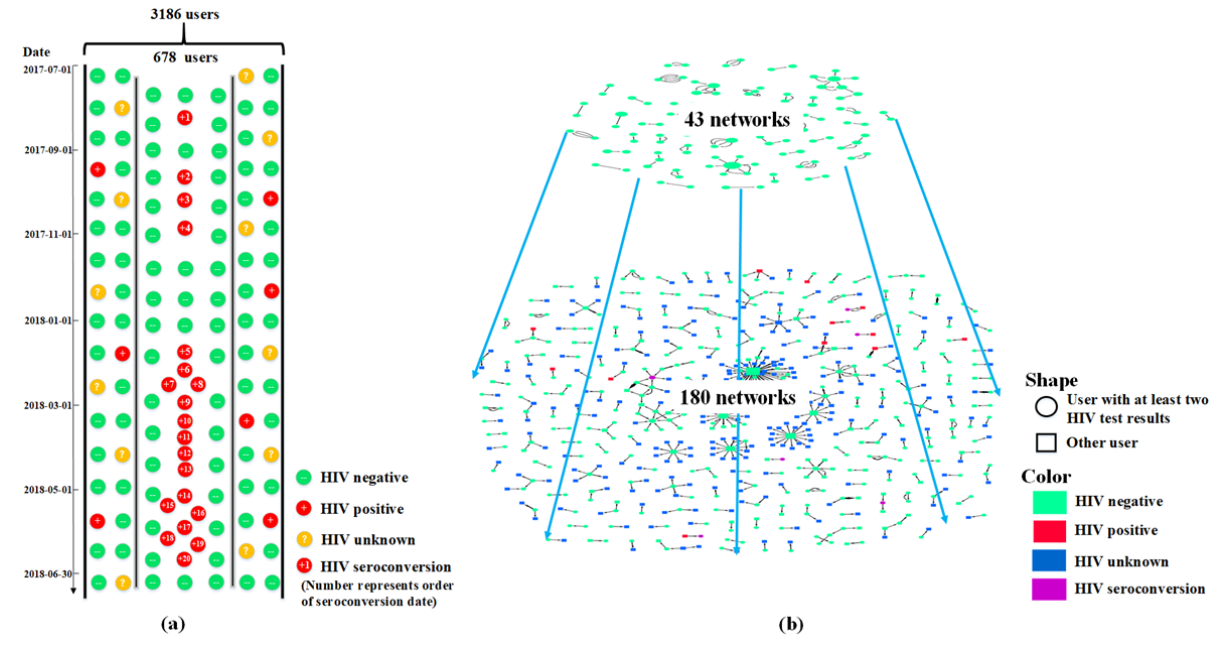
Figure 6. Extension of men who have sex with men (MSM) users and the two-tier